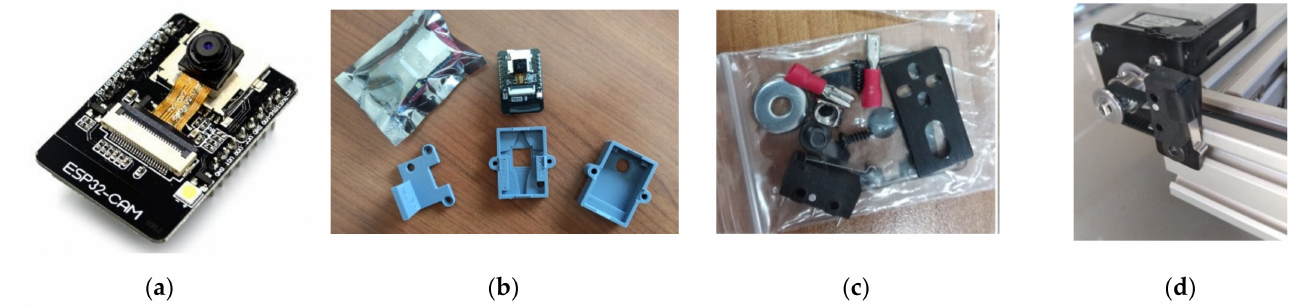
Figure 8. ( a ) ESP-32 CAM; ( b ) Camera, camera casing design and 3D printed casing; ( c ) Limit switch components and; ( d ) Installed limit switch.